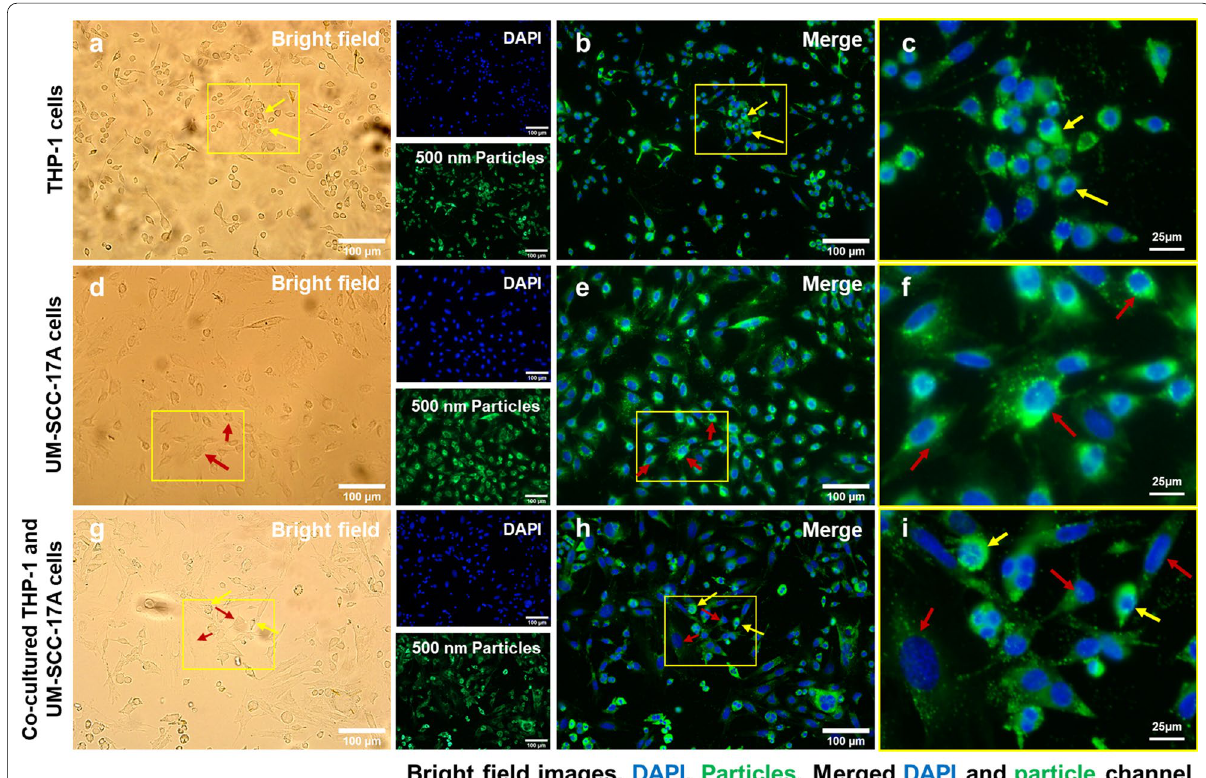
Fig. 5 Microscopic examination of cellular internalization of 500 nm PLGA nanoparticles in monoculture and co‑cultured cells. Single type of cells or mixed cells was treated with 500 nm PLGA nanoparticles for 24 h at 37 °C at a concentration of 10 µg/mL. Cells were observed under bright‑field ( a , d , g ) and fluorescent channels ( b , e , h ) with particles observed at the green channel and cell nuclei in the blue channel after stained with Hoechst. Massive cellular ingestion of 500 nm PLGA nanoparticles can be visualized in magnified images ( c , f , i ) for monoculture THP‑1 macrophages (yellow arrows) and laryngeal cancer cells UM‑SCC‑17A cells (red arrows). In the co‑culture system, 500 nm PLGA nanoparticles were still highly uptake by macrophages, while cancer cells had inadequate particle